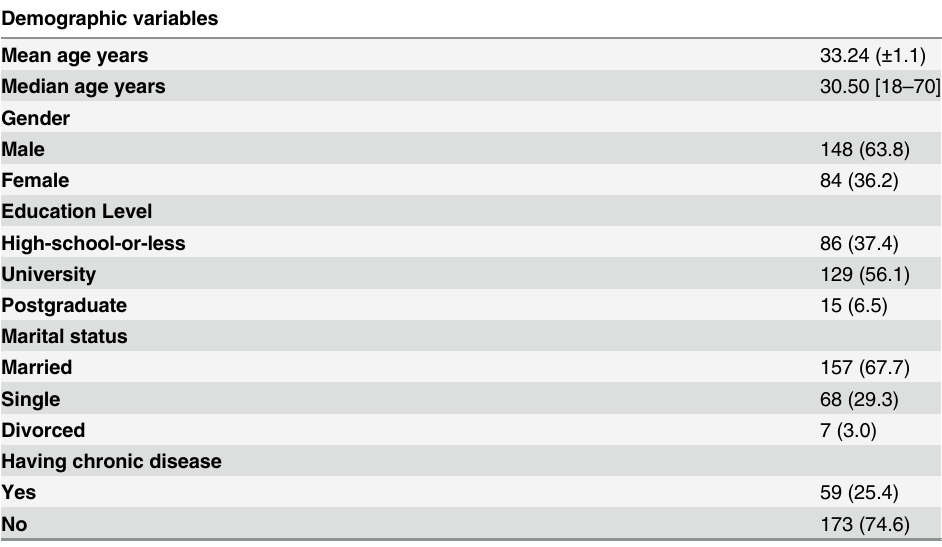
Table 1. Independent variables of